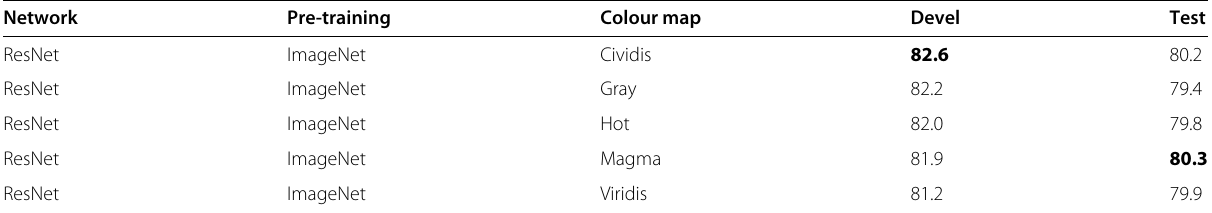
Table 2 Evaluation of the impact different colour maps have on the efficiency of an ImageNet pre-trained ResNet as an audio feature extractor on DCASE 2018’s domestic activity classification task. All results are given in macro average F1